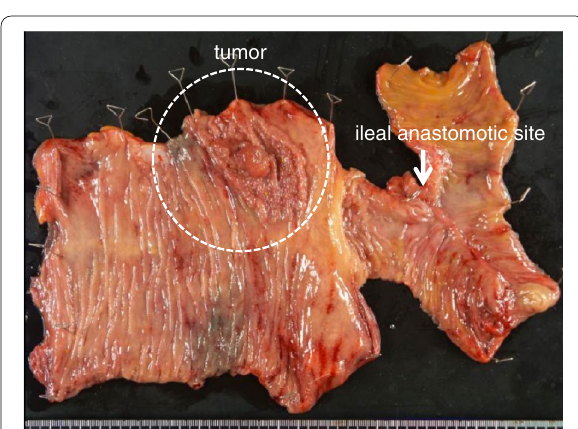
ileal anastomotic